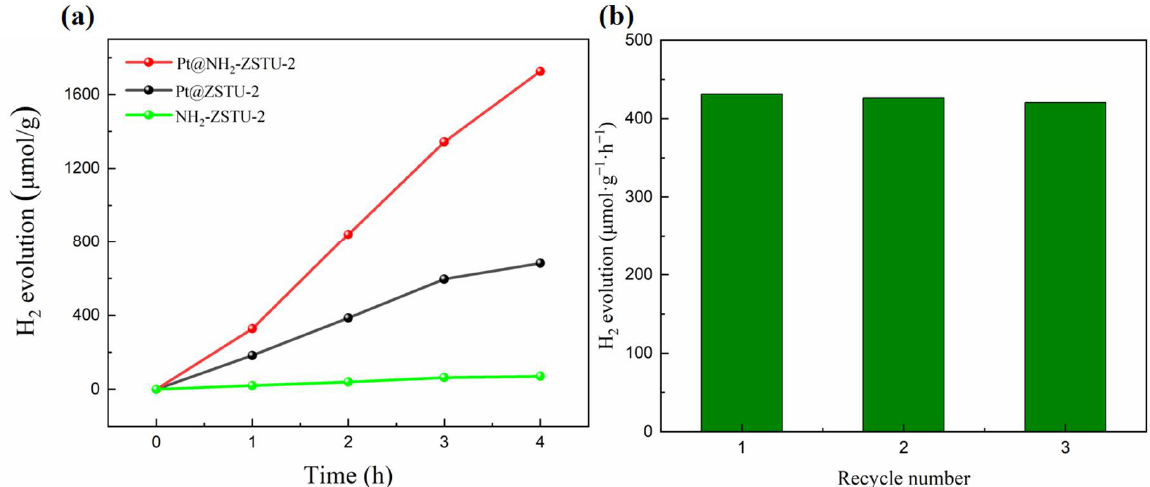
Figure 7. Photocatalytic performance. ( a ) Time-dependent photocatalytic hydrogen production of Pt@ZSTU-2, Pt@NH 2 -ZSTU-2, and NH 2 -ZSTU-2 in triethanolamine/acetonitrile/water system under visible light irradiation; ( b ) recycle performance of Pt@NH 2 -ZSTU-2 under same condition.